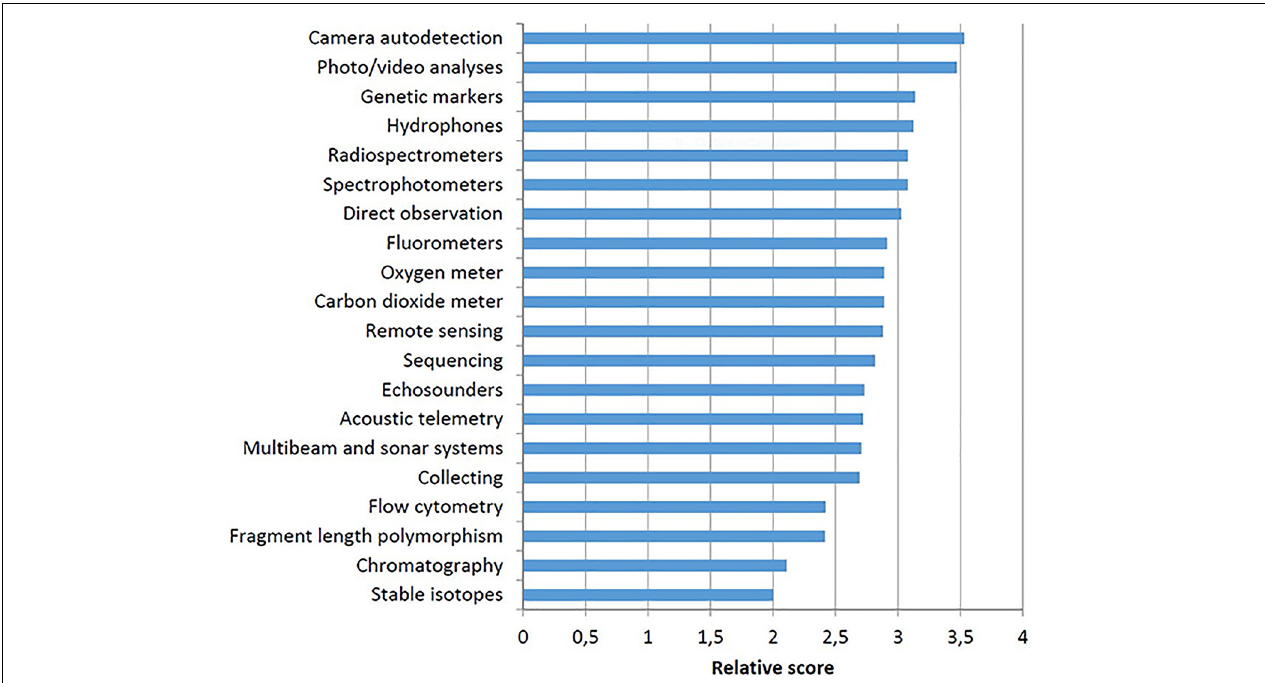
FIGURE 2 | Ranking and relative scores of potential methodologies for assessing biodiversity to be integrated in the JERICO-RI network. Taken from JERICO-FP7 D1.9 by Wijnhoven (2014).